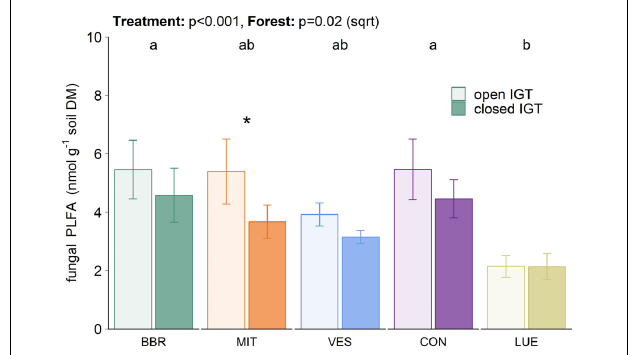
FIGURE 3 | Fungal biomass in open and closed ingrowth tubes (IGTs) based on phospholipid fatty acid analysis in Bad Brückenau (BBR), Mitterfels (MIT), Vessertal (VES), Conventwald (CON), and Lüss (LUE) after 18 months of exposure ( n = 5). Forests sharing no letter are significantly different and asterisks highlight significant differences between open and closed IGTs at the respective forest